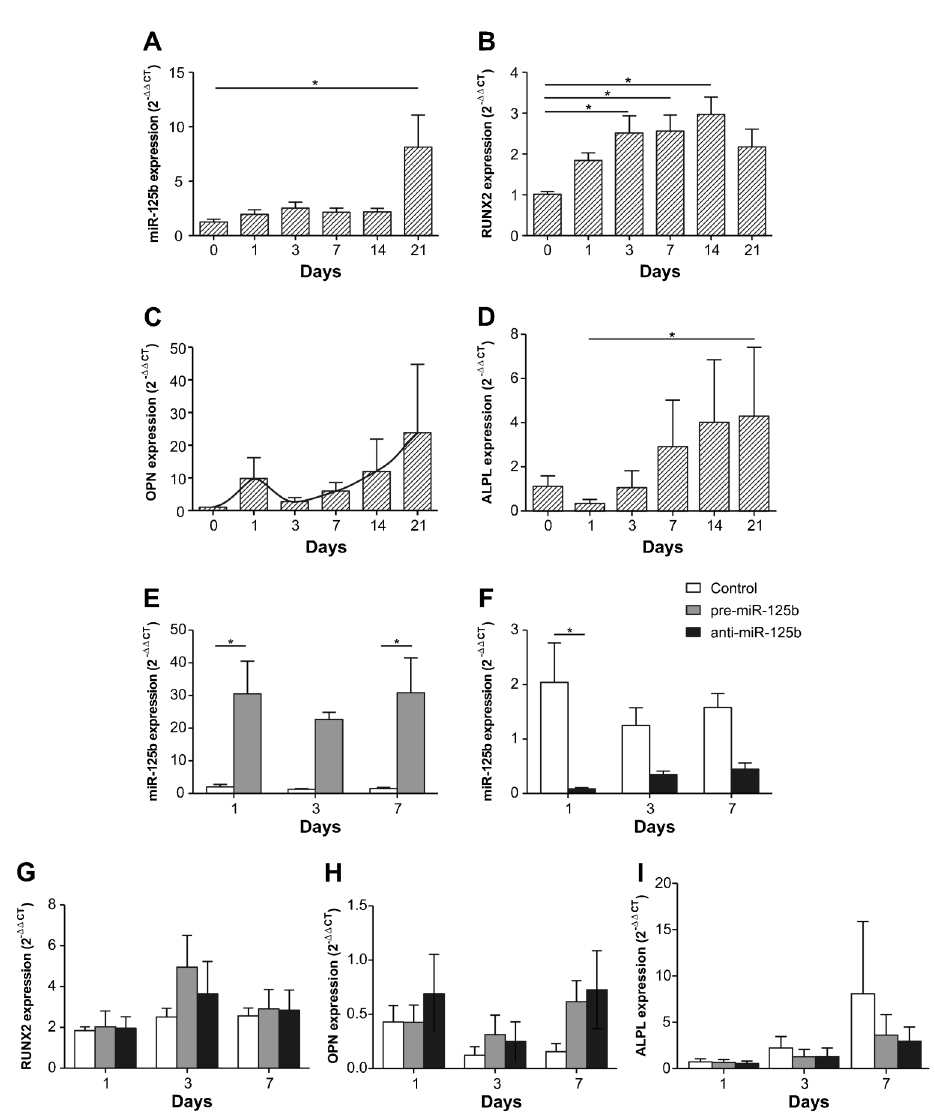
Figure 2. miR-125b, Runx2, OPN, and ALPL expression during osteoblastic differentiation analyzed by qRT-PCR. A , miR-125b expression was increased on day 21. mRNA levels of osteoblastic markers Runx2 ( B ), OPN ( C ), ALPL ( D ). Significance was determined by the Kruskal-Wallis test and the Dunn post-test (*P # 0.05). Pre-miR-125b ( E ) and anti-miR-125b ( F ) were transfected into mesenchymal stromal cells (MSCs) and miR-125b expression was measured. Runx2 ( G ), OPN ( H ), and ALPL ( I ) gene expression was analyzed in MSCs transfected with pre-miR-125b and anti-miR-125b. Negative controls were used in all experiments. Cells were cultured in osteoblastic differentiation medium and harvested on the indicated days. Runx2: runt-related transcription factor 2; OPN: osteopontin; ALPL: alkaline phosphatase. Differences in gene expression were analyzed by two-way ANOVA followed by the Bonferroni post-test (*P # preosteoblasts. Preosteoblasts express Runx2, distal- less homeobox 5, and msh homeobox homologue 2 and differentiate into immature osteoblasts, which express bone morphogenetic protein 2, Osterix, b -catenin, bone matrix proteins, bone sialoprotein, and OPN. At that point, immature osteoblasts develop into mature osteoblasts that express osteocalcin, ALPL, and type I collagen (17).